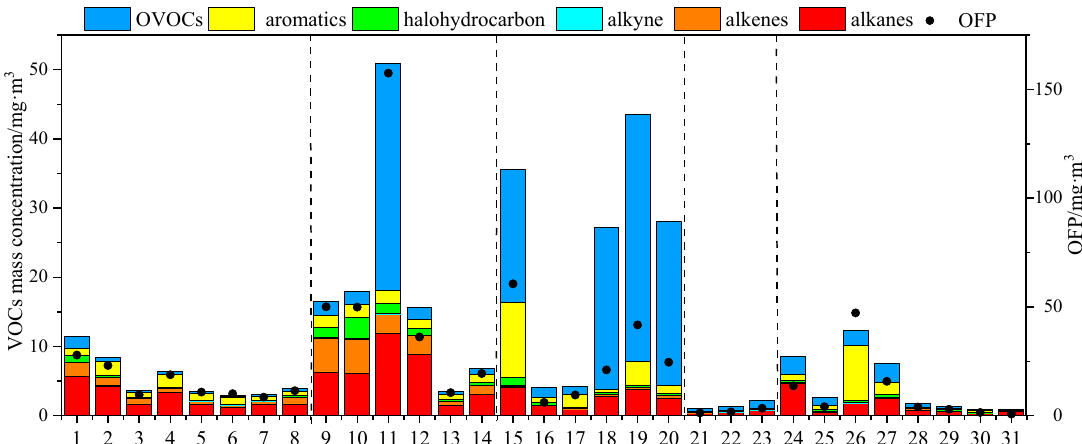
Figure 4. VOC emission concentrations and OFPs in various industries.